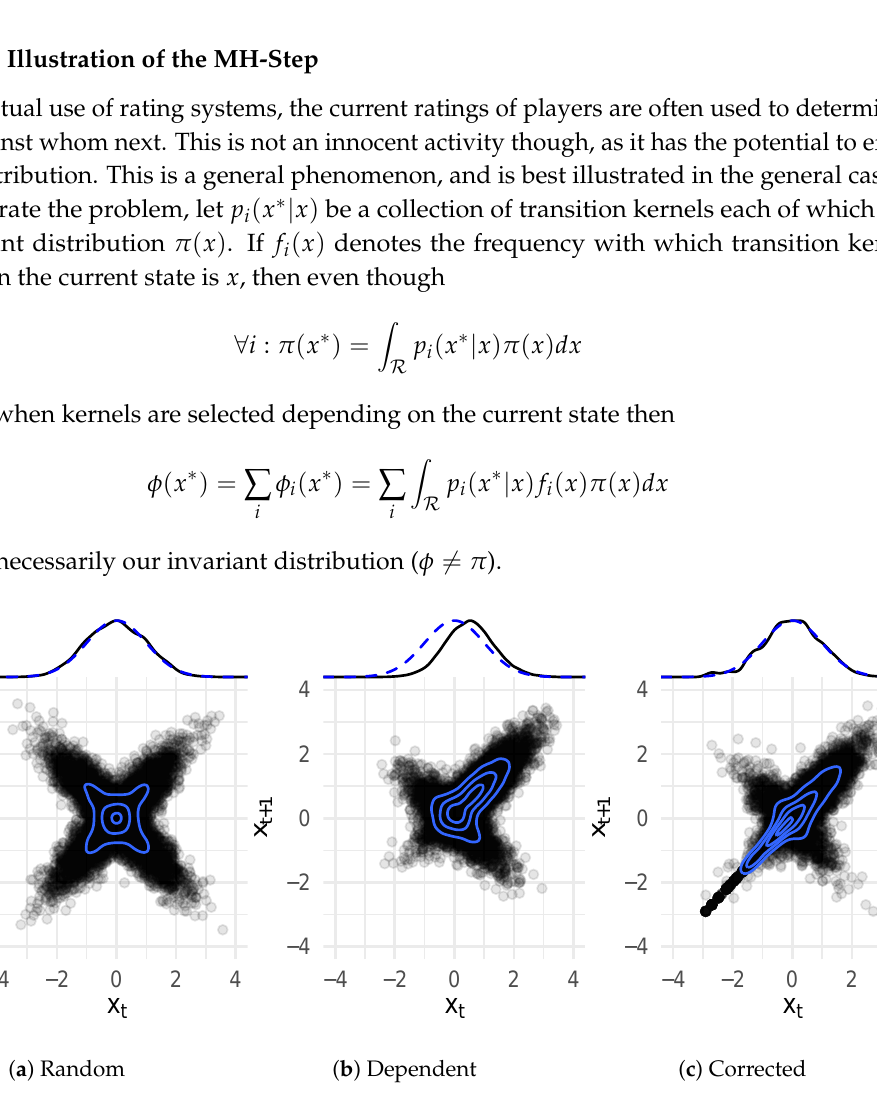
Figure A1. Joint distribution of the current and the new states of the Markov chain and the invariant distribution of the chain (black curve on top) compared to the standard normal distribution (blue dashed curve). where ( a ) the transition kernel is selected randomly, ( b ) the transition kernel is selected dependent on the current state, and ( c ) the transition kernel depends on the current state, but this dependence is corrected for in a Metropolis–Hastings